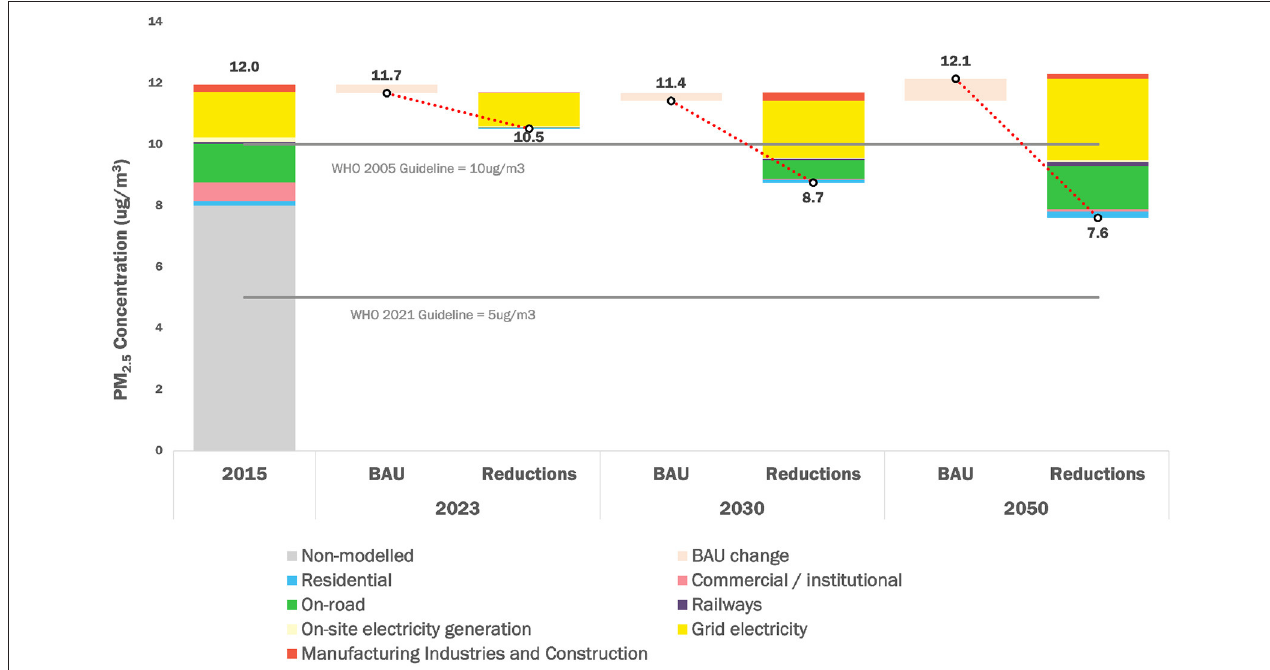
FIGURE 5 | Changes in annual average PM 2.5 concentrations in Buenos Aires for the three time horizons (2023, 2030, and 2050), comparing the BAU scenario with the “Ambitious” scenario. Peach-colored bars show how BAU concentrations are projected to change between periods based on global modeling (lower in 2023 and 2030, but rising by 2050). The Pathways-AQ model only captures 4 µ g/m 3 of the estimated 12 µ g/m 3 total concentration drawn from the Global Burden of Diseases (GBD) PM 2.5 concentrations, matched to the city boundaries and population weighted for the base year of 2015, as the model includes only contributions from sources within the city (and none of the “outside city” contributions). The Pathways-AQ model also does not capture all emission sources in a city, such as natural sources, dust from the construction sector, emissions from barbecue grills, certain commercial processes, some forms of residential fuel use, and can often miss important sources of biomass incineration and burning (e.g., see lessons